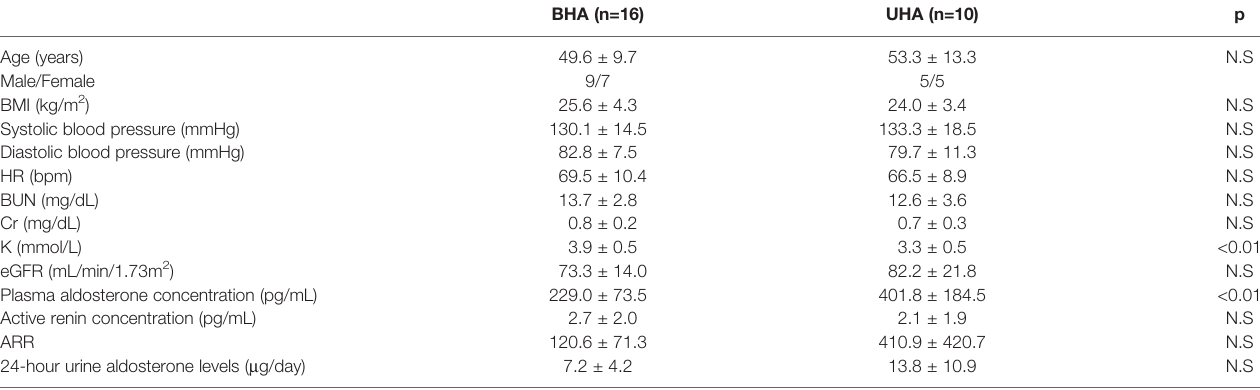
TABLE 2 | Baseline Clinical Characteristics of the patients with bilateral hyperaldosteronism and unilateral